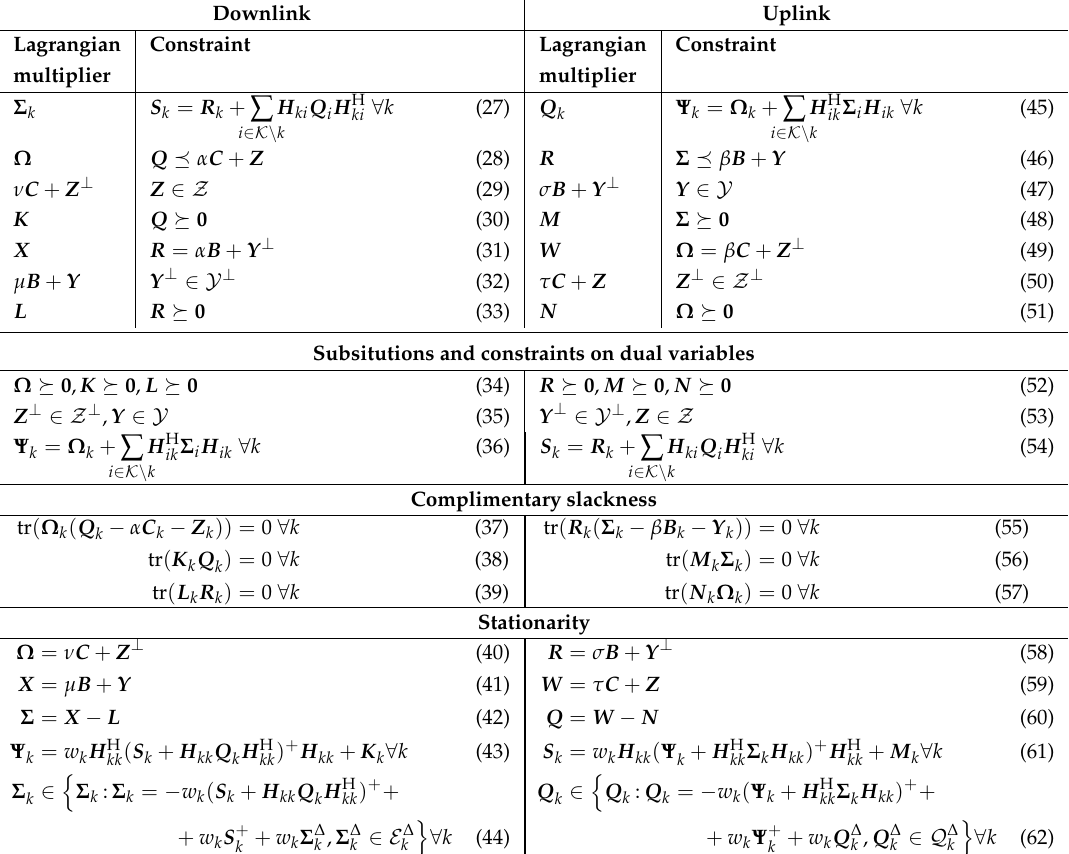
Table 1. Uplink and Downlink Optimality